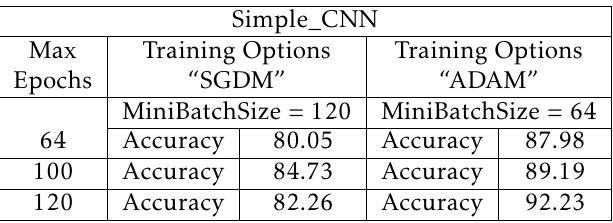
Table 1. Comparison between ADAM and